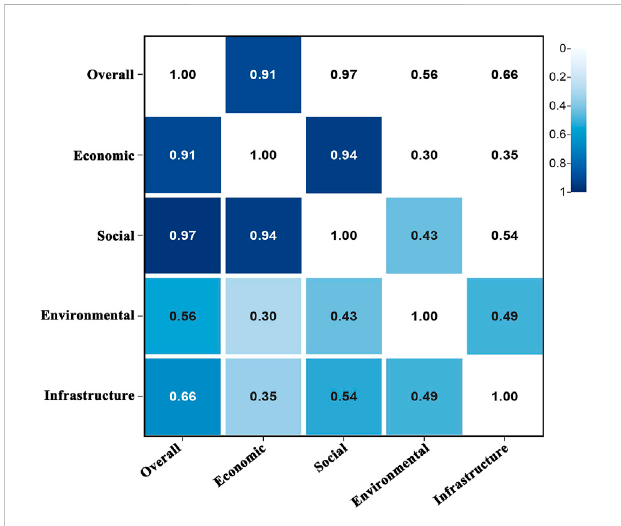
FIGURE 7 Pearson correlation coef fi cient for each aspect.